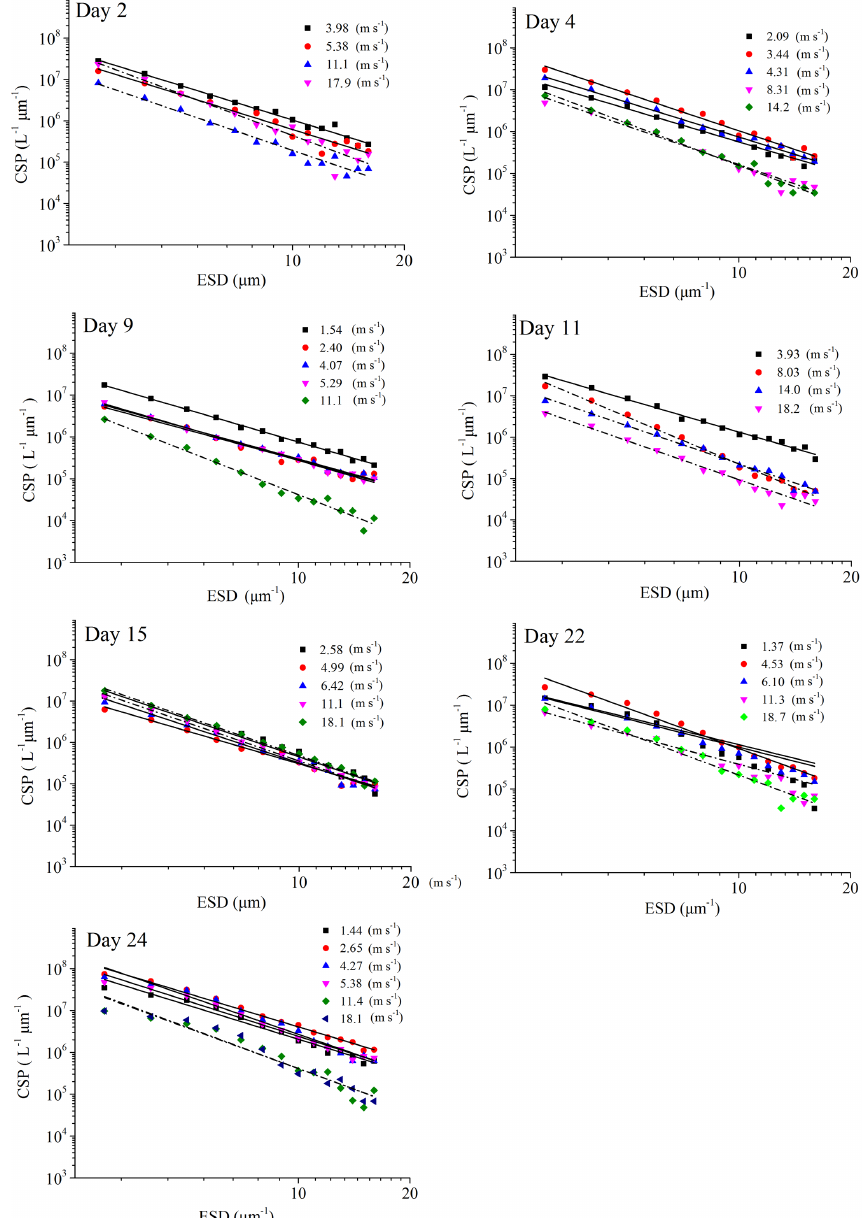
Figure 5. PSD of CSP SML at different wind speeds (linear regressions of log ( d N/ d (d p )) vs. log (d p ) was fitted to particles in the size range of 2–16µm ESD, with wind speeds < 8ms − 1 (solid line) and wind speeds > 8ms − 1 (dash and